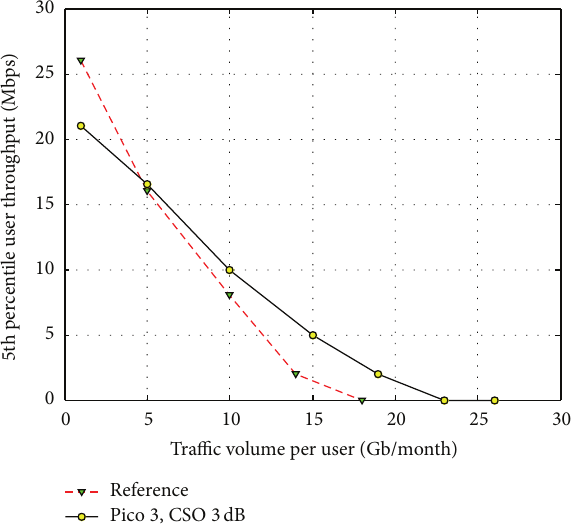
Figure 5: Cell-edge UE throughput with and without PeNB [6].